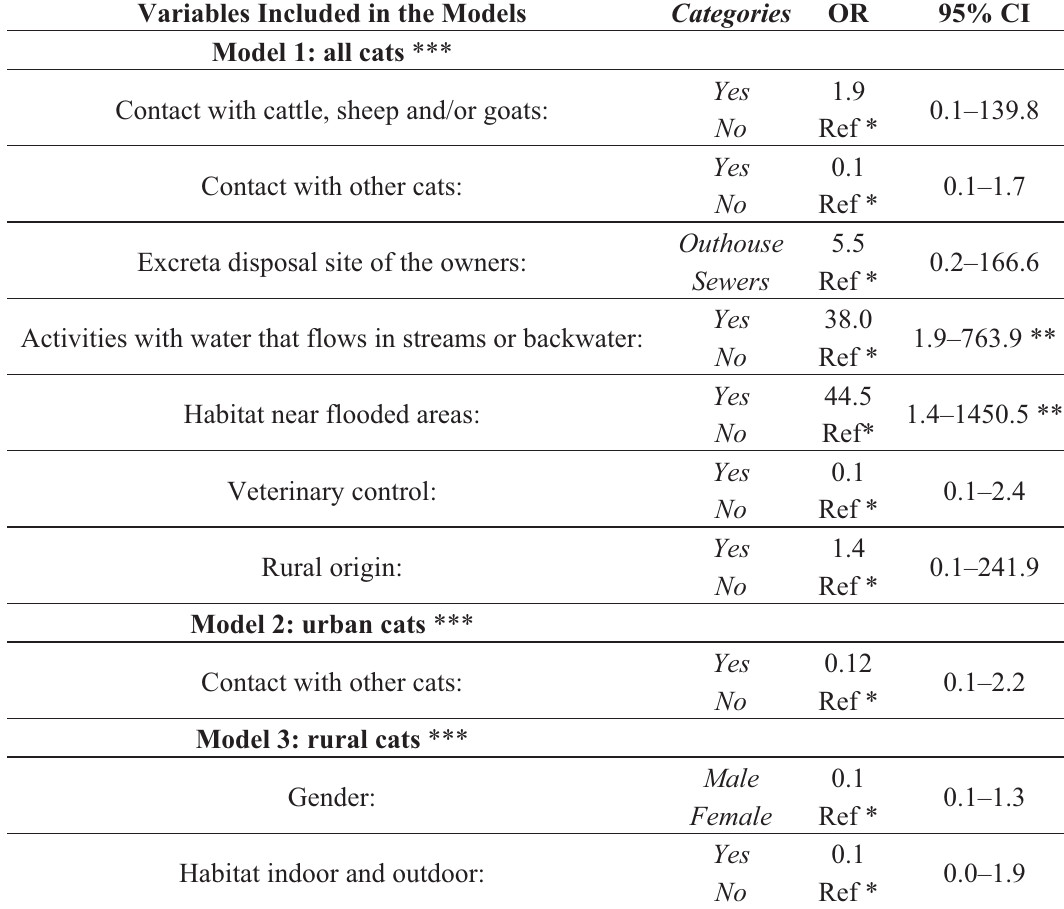
Table 5. Conditional logistic regression models to identify risk factors associated with the seropositivity in